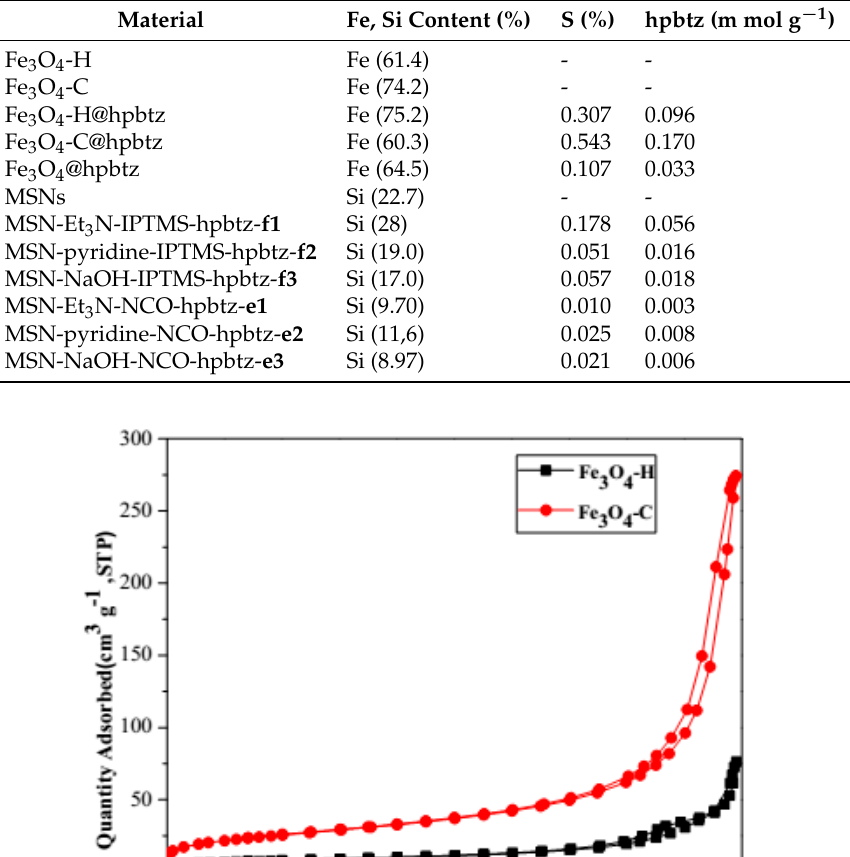
Table 2. Composition of synthesized materials determined by XRF.